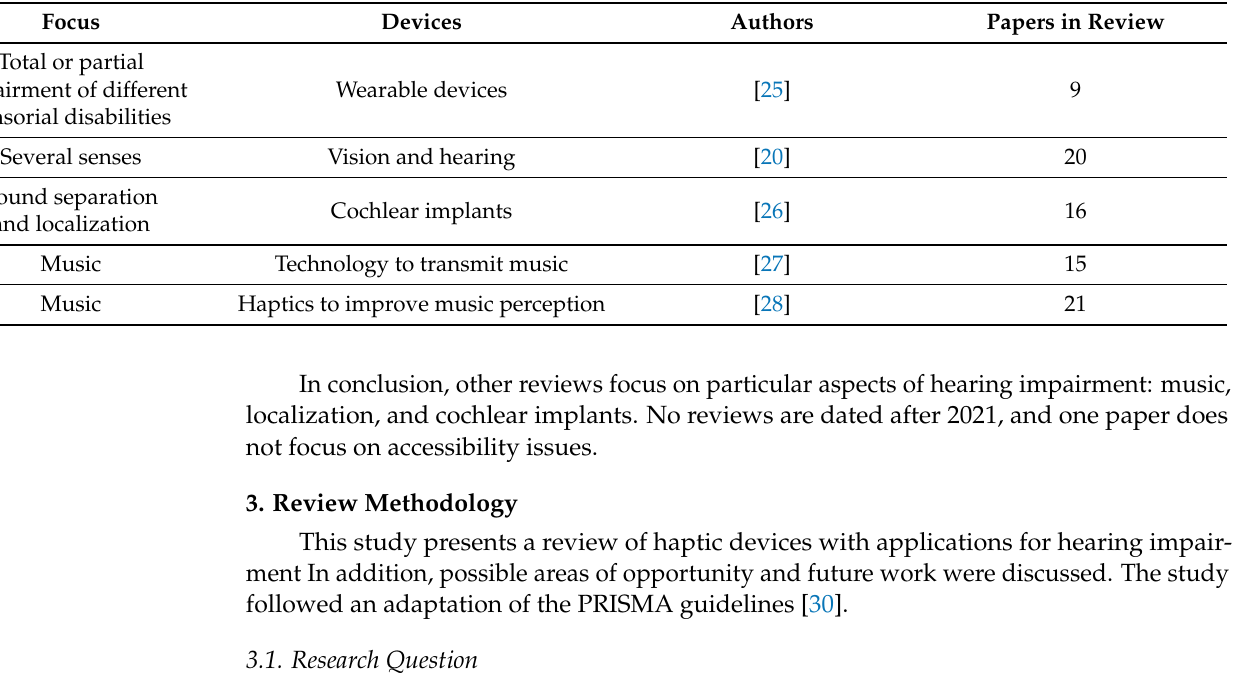
Table 1. Other literature review